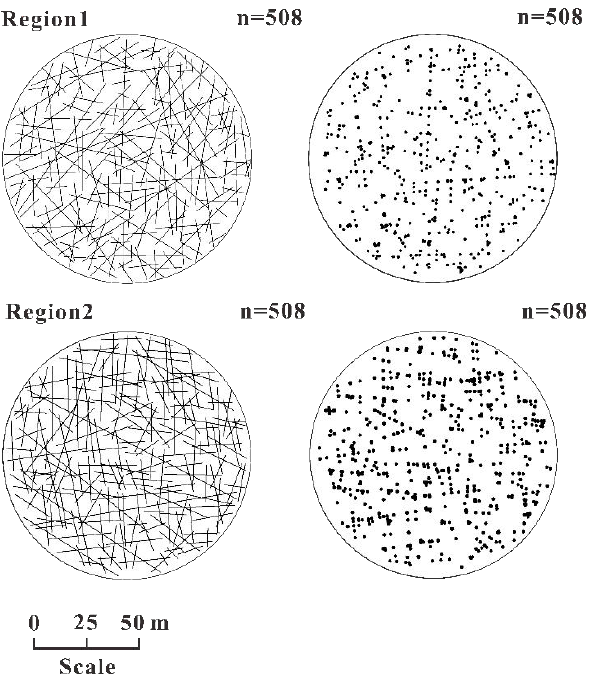
Figure 16. Digital lineament strength and density map. Lineaments extracted from study area 1 and 2 by the traditional Canny algorithm (n represents the number and intersections of lineaments).